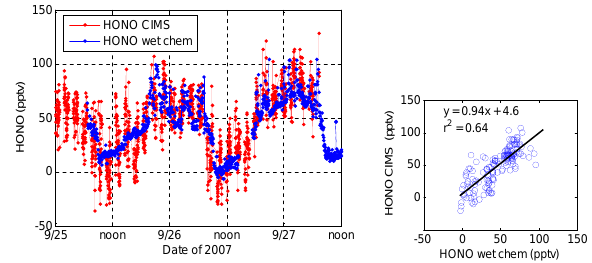
Fig. 5. Comparison of HONO measurements by wet chemistry (blue dots) and CIMS (red circles) over three days between 25 and 27 September, 2007. Left: time series with one-minute averages. Right: scatter plot of CIMS HONO versus wet chemistry HONO with 10-min